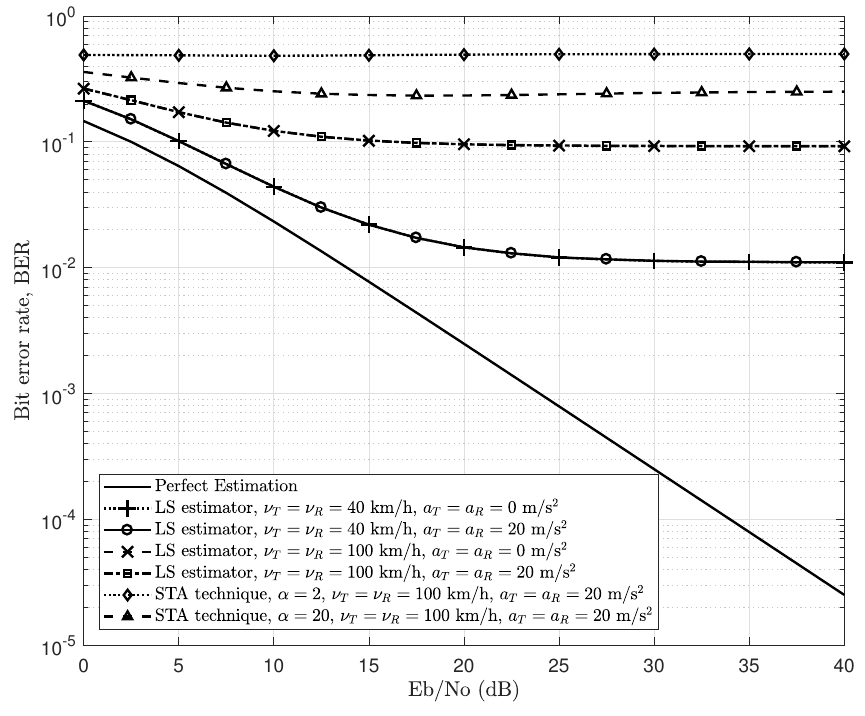
Figure 8. System performance by considering different initial speeds and acceleration components for Scenario I with a constant frame length of F =